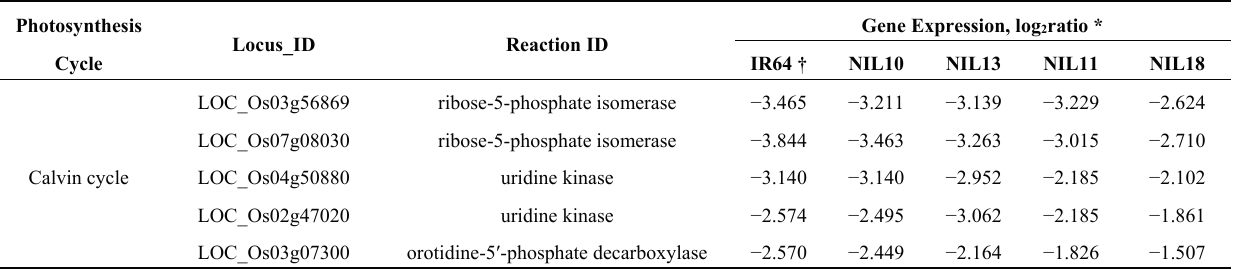
rice genotypes including two pairs of near-isogenic lines (NILs) and their susceptible parent (IR64) in response to severe drought stress